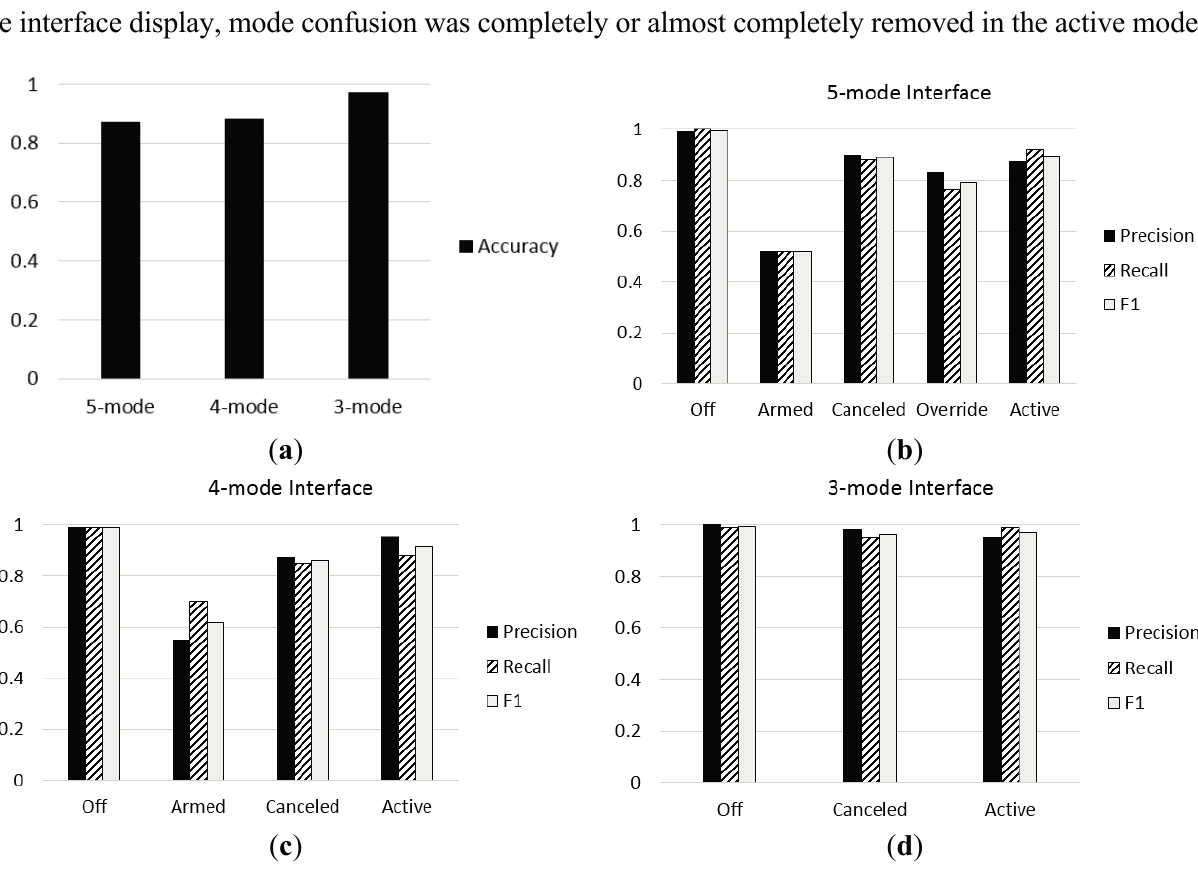
Figure 14. Performance evaluation results for the three types of interfaces: ( a ) accuracy; ( b ) precision, recall, and F1 measure of the five-mode interface; ( c ) precision, recall, and F1 measure of the four-mode interface; and ( d ) precision, recall, and F1 measure of the three-mode